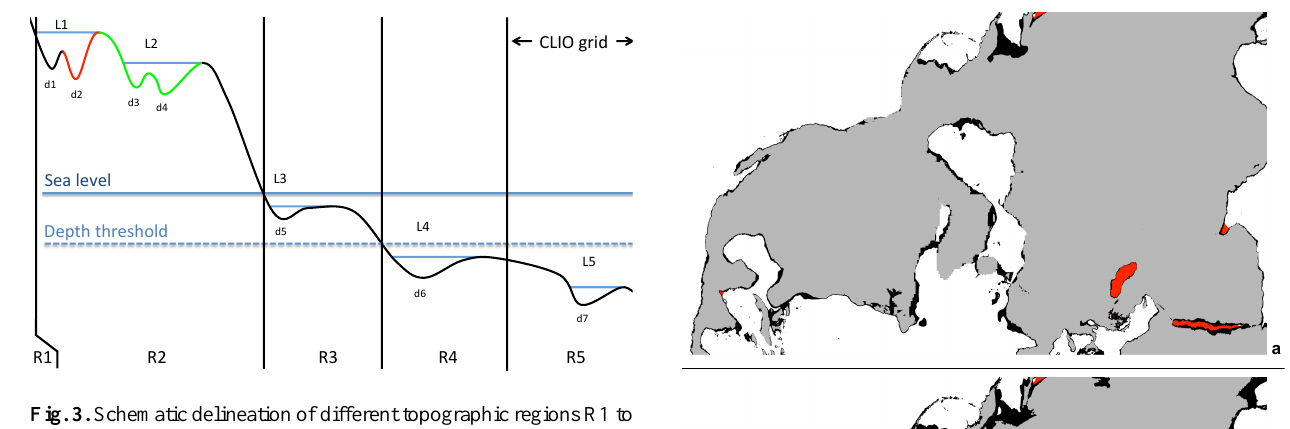
Fig. 3. Schematic delineation of different topographic regions R1 to R5. Depressions are marked d1 to d7 and lakes L1 to L5. All grid points connected to the same lowest point of a depression (example d2) form a drainage basin (red). Drainage basins connected to the same lake (example L2) form a lake catchment (green). See text for further details.